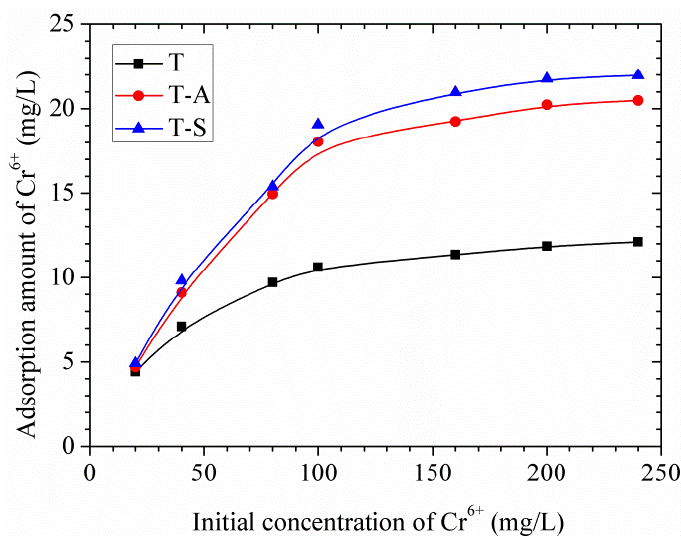
Figure 10. Effects of initial concentration of Cr(VI) on adsorption amount of Cr(VI). Table 3. Langmuir isotherm model for the Cr(VI) adsorption by the tobermorite samples. Sample Langmuir Isotherm